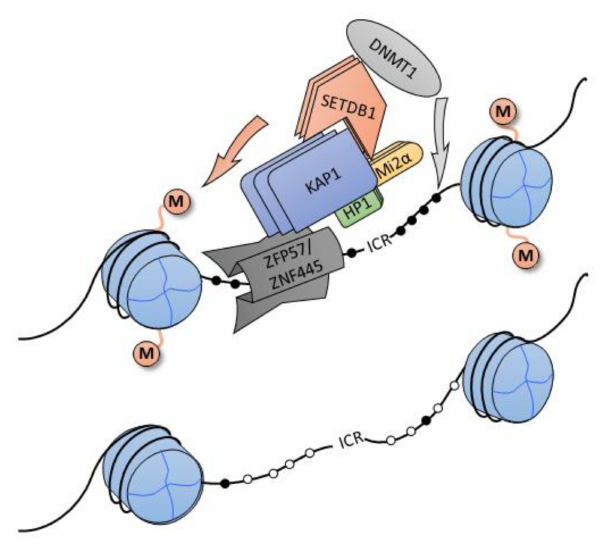
Figure 3. The involvement of ZFP57 and ZFP445 in gene imprinting. Both ZFP57 and ZNF445 are involved in maintaining methylation patterns by recruiting KAP1, DNA methyltransferase DNMT1, and histone methyltransferase SETDB1 to induce H3K9 trimethylation. The methylated imprinting control regions (ICR) on the top (black circles), unmethylated ICR on the bottom (white